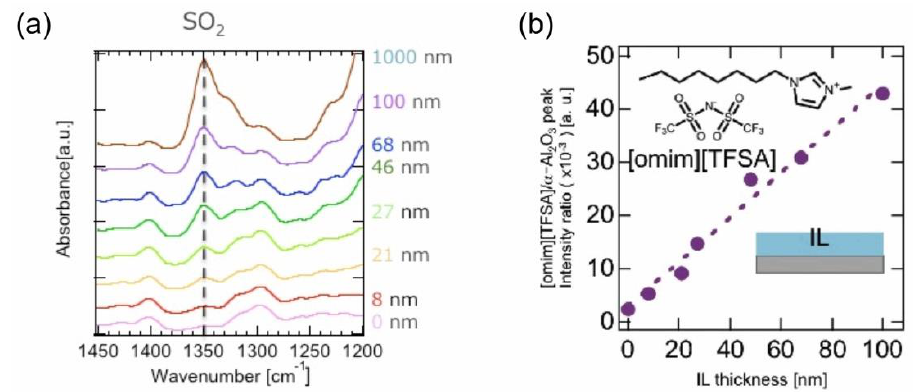
Figure 2. ( a ) IR absorption spectra of [omim][TFSA] IL films with different thicknesses. ( b ) Linear increase in the peak intensity of the absorption band at around 1350 cm −1 attributed to the SO 2 vibration mode of TFSA anions with the film thickness between 10 nm and 1000 nm (note that 1000 nm-thick IL film was prepared by spin coating). Reproduced with permission from ref. [20]. Copyright 2018, The Chemical Society of Japan.